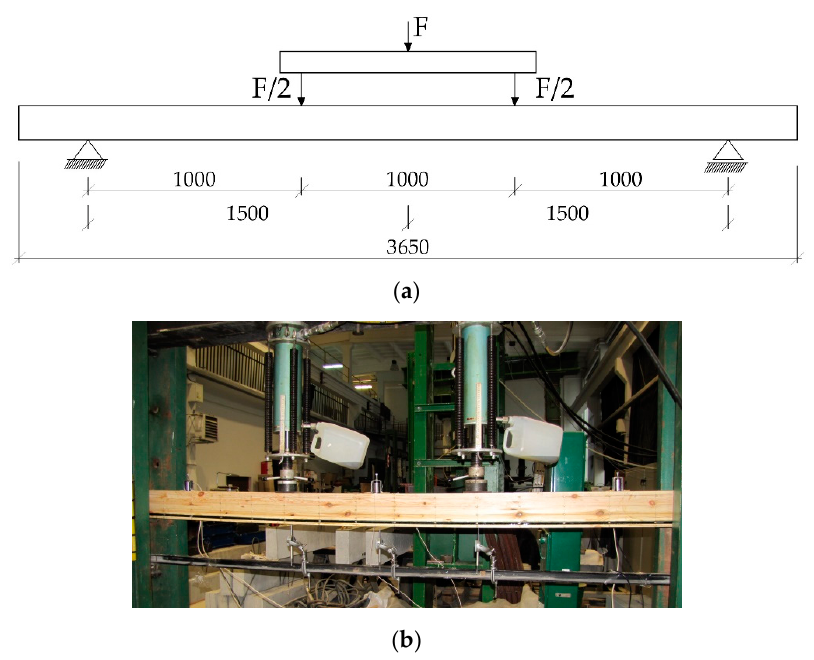
Figure 3. Testing station plan: static scheme [dimensions in mm], b ) view of the test stand for the Wa-B2 beam.